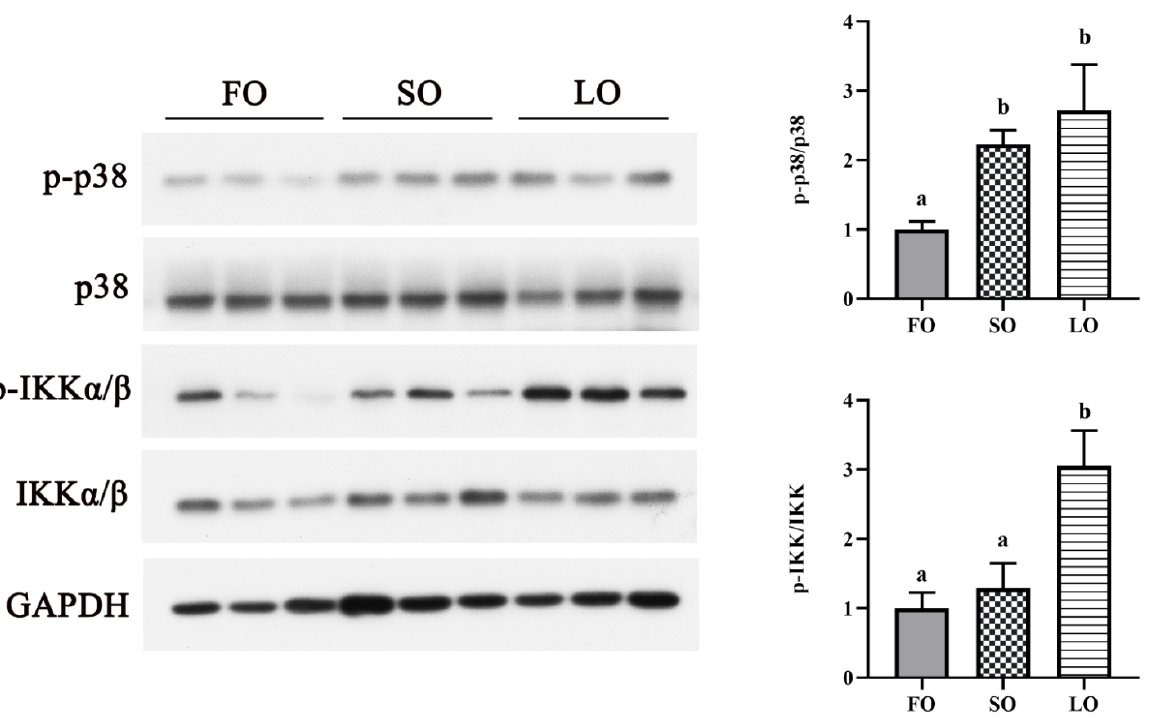
Figure 5. Effects of dietary SO and LO on the activation of p38 MAPK and NF- κ B signaling pathways in adipose tissue of large yellow croaker. Results are presented as the means ± S.E.M. and were analyzed using Tukey’s test (n = 3). Bars labeled with the same letters are not significantly different ( p > 0.05).